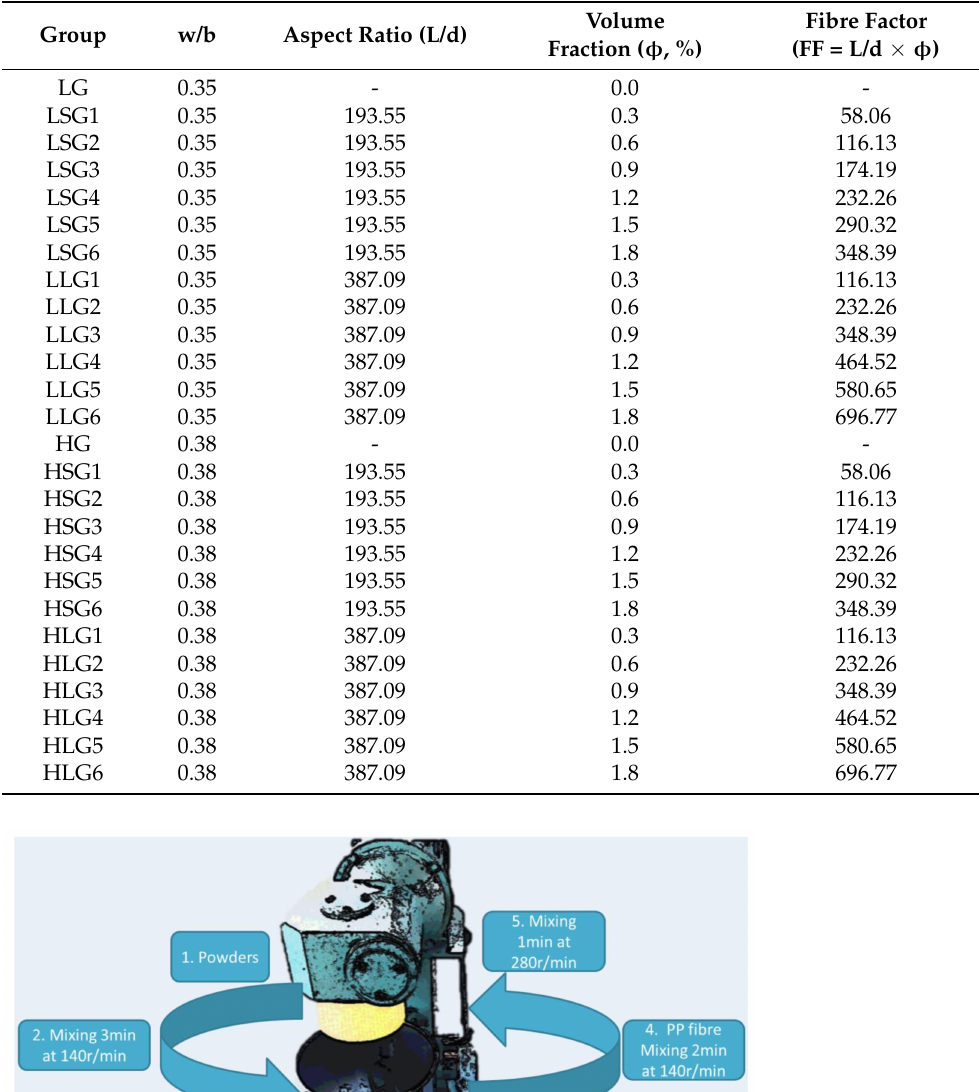
Table 3. Mixture proportions of fibre-reinforced geopolymer.